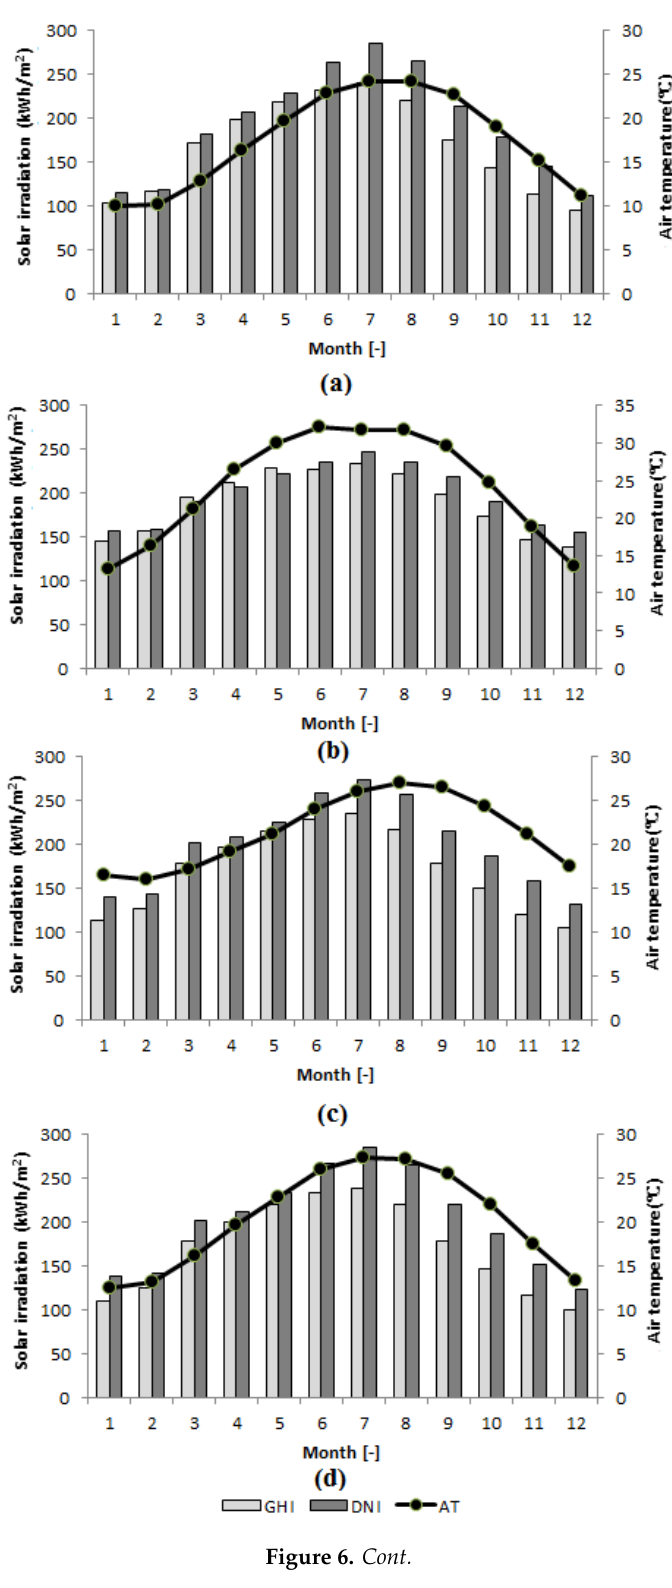
Figure 6. Figure 6. Mean monthly global horizontal irradiation, direct normal irradiation and air temperature for all selected regions in Libya; ( a ) Al bayda, ( b ) Al-kufrah, ( c ) Benghazi, ( d ) Darnah, ( e ) Espiaa, ( f ) Misratah, ( g ) Nalut, ( h ) Sabha, and ( i ) Tripoli.